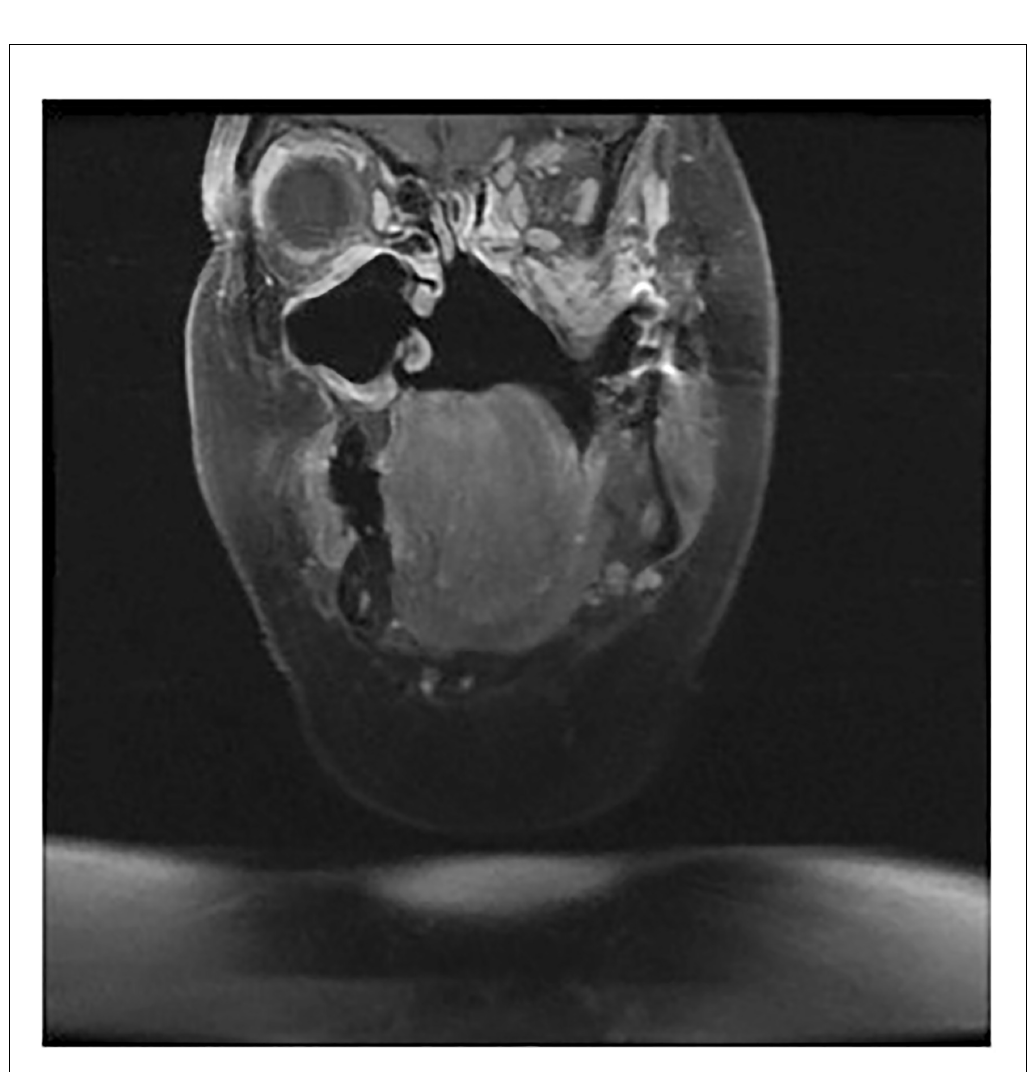
Figure 1. Coronal CT scan showing recurrence of tumour involving left masticator